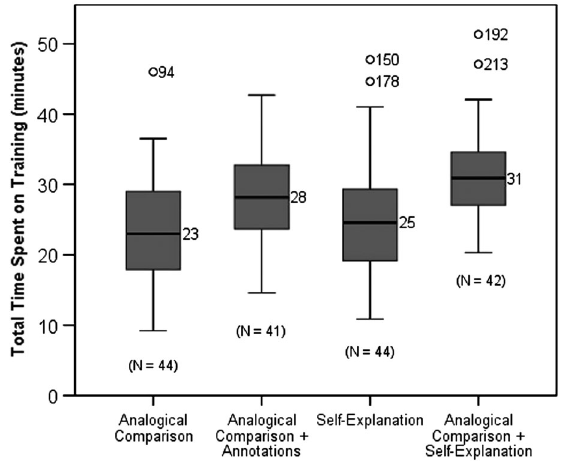
FIG. 9. Proportion of students in each condition demonstrating the correct general solution structure on the target problem. Error bars are standard errors.